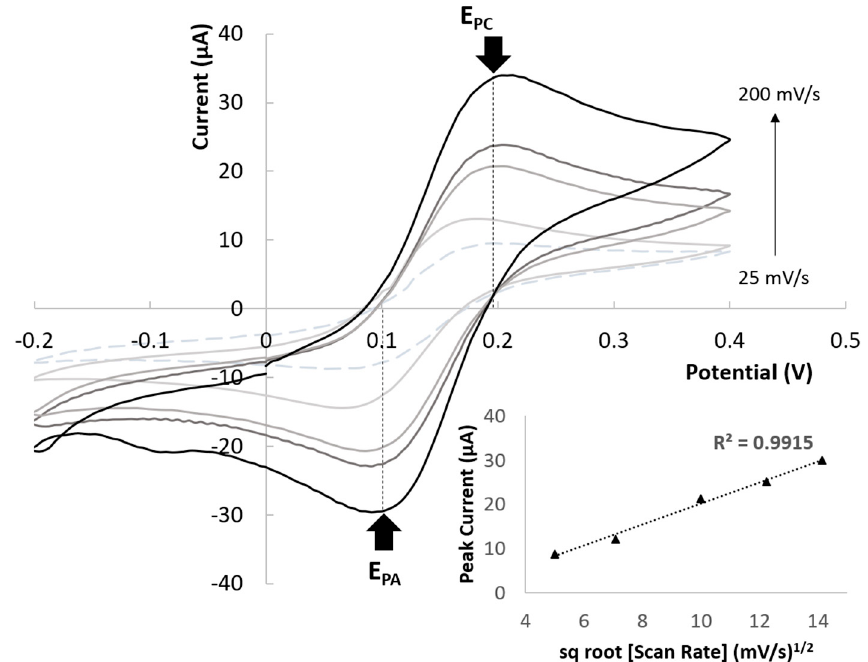
Figure 8. Electrochemical characterization of AJP sensors in presence of 5mM Ferri-ferrocyanide solution. Cyclic voltammetries at increasing scan rates (25, 50, 100, 150, and 200 mV/s) and linear relation between peak current height and the square root of the scan rate confirming the diffusion control of the reaction.